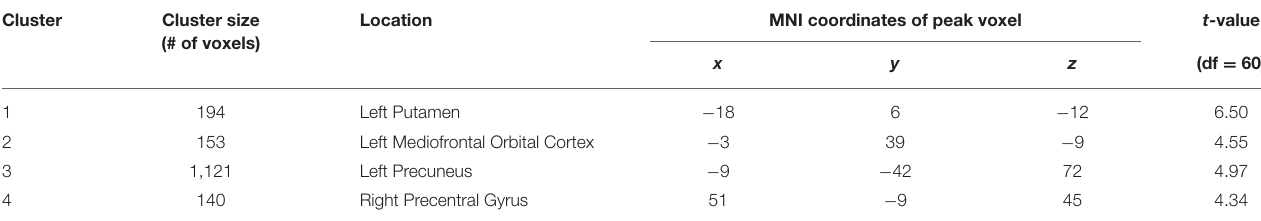
TABLE 4 | Brain clusters with significant differences in FC changes for left amygdala after exposure to criticism. Cluster Cluster size Location MNI coordinates of peak voxel t -value (# of voxels)